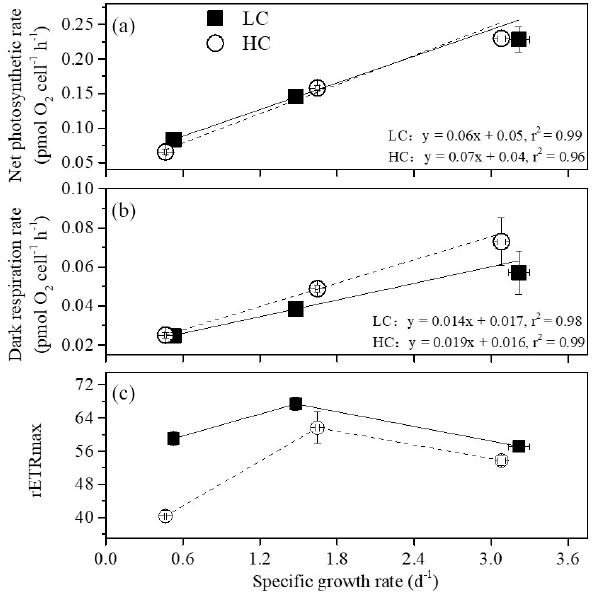
Figure 4. The relationship between net photosynthetic rate (a) , dark respiration (b) , rETR max (c) and specific growth rate of S. costatum acclimated to ambient (LC, black square) and elevated p CO 2 (HC, white circle) under different combinations of temperature and pho- toperiod conditions. The data are mean ± SD values of triplicate cultures ( n = 3).